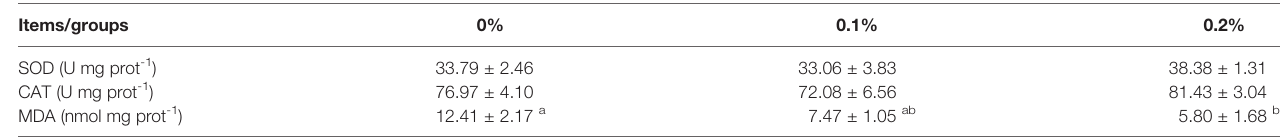
The values (n = 6) are expressed as mean ± standard error. The mean values in same line with different superscripts are signi fi cantly different (p <